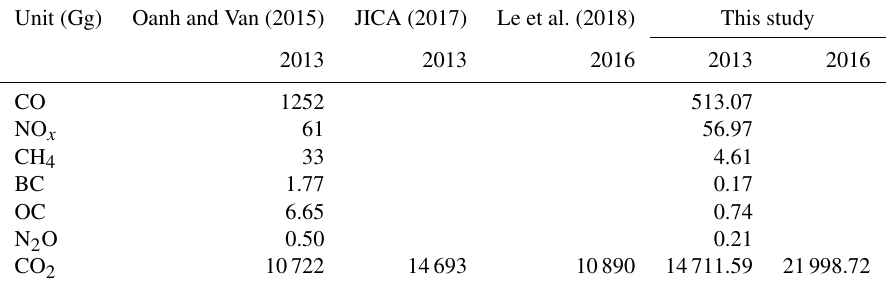
Table 13. Comparison of transportation emissions estimated in this study with emissions calculated in previous studies for 2013 and 2016. Values in italics refer to emissions estimated for